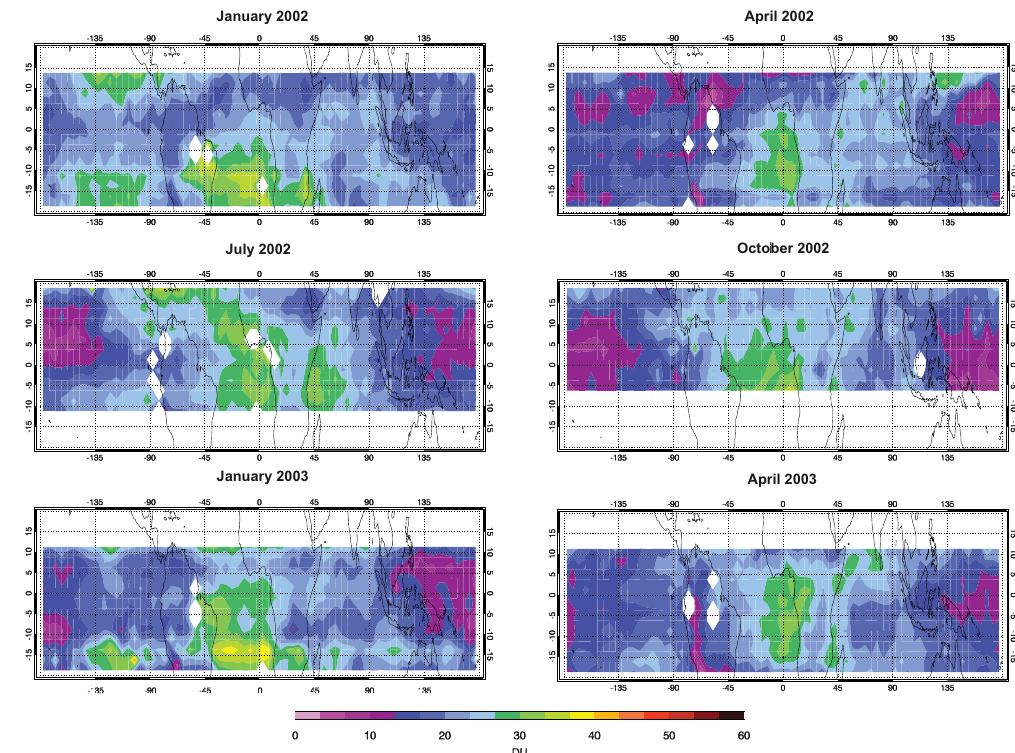
Figure 9. Tropical tropospheric ozone column (TTCO) derived with the convective cloud differential (CCD) technique for January, April, July, and October 2002 and January and April 2003 using GOME